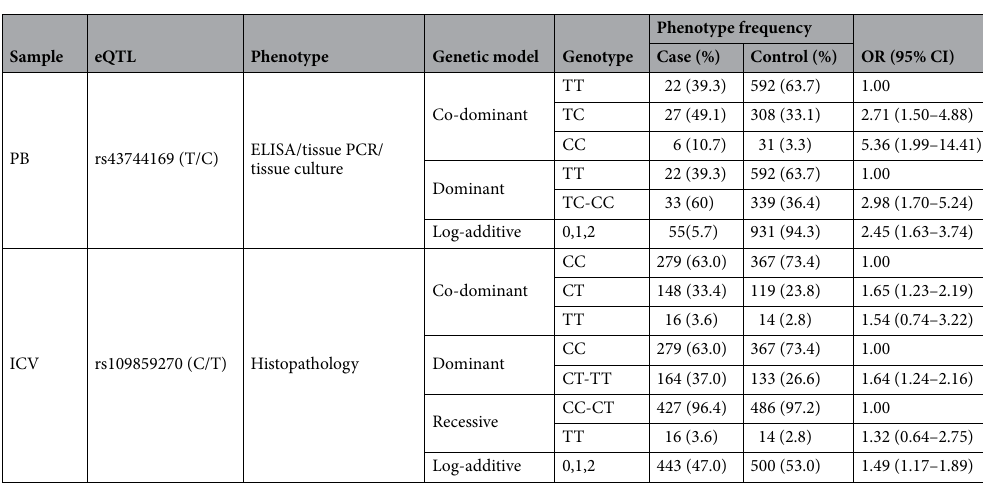
Table 4. Frequencies of the rs43744169 and rs109859270 genotypes and the odds ratio for each genetic model. PB peripheral blood, ICV ileocecal valve, OR odds ratio, 95% CI 95% confidence